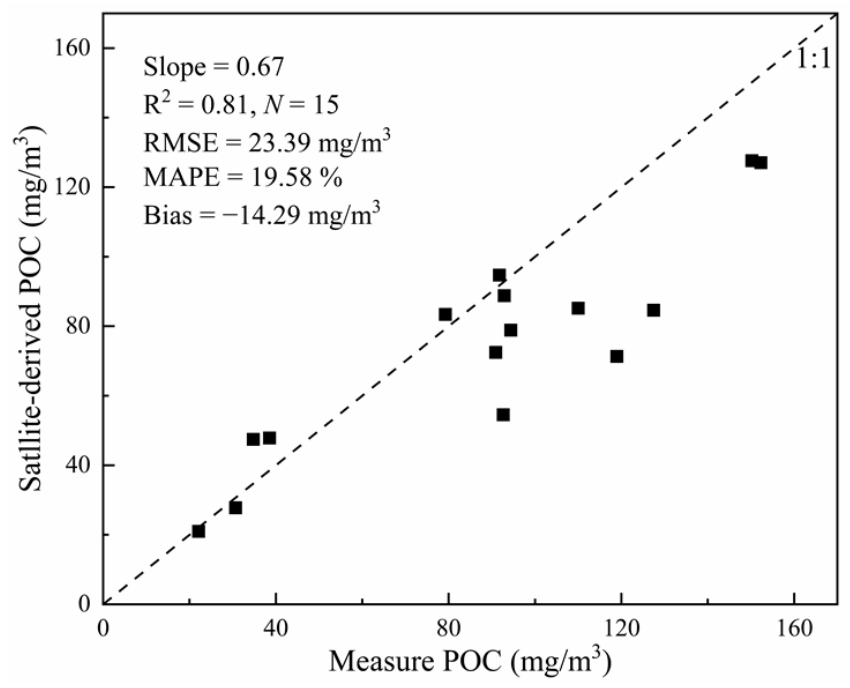
Figure 10. Comparison of in-situ POC and MODIS-derived POC concentration in Chaoshan sea.